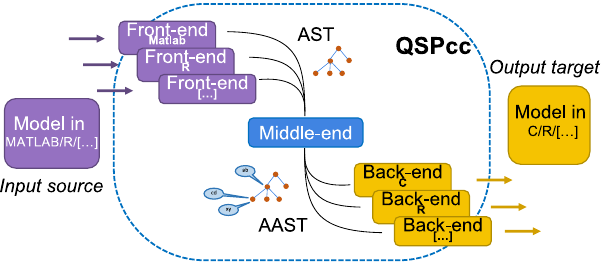
Fig. 6 High-level QSPcc compiler organization. The sequence of transformations the input source code undergoes during the translation is rooted in formal methods in computer science supporting the biological applications described here. A bird eye outlook shows how a dynamical phenomenon, as the LSD family of models, written in a source programming language is transformed in a Tree (AST). This is further semantically annotated becoming a formal data structure (AAST) allowing to understand the meaning of the original model to guide the construction of a more ef fi cient representation in a